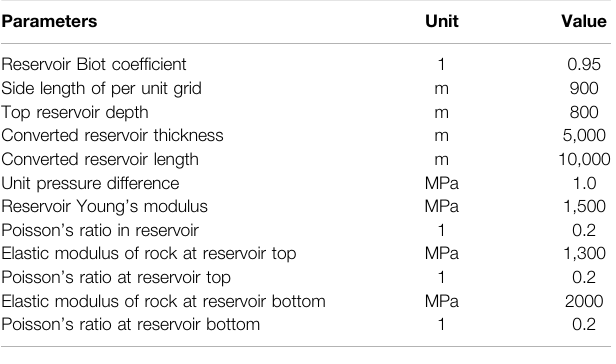
Based on fi nite-element analysis, the distribution of the surface vertical displacement caused by the pressure difference in the The relationship between the surface displacement and pressure difference is represented by the convolution kernel k (x, y) for the analyzed block. For the fi nite element model, the